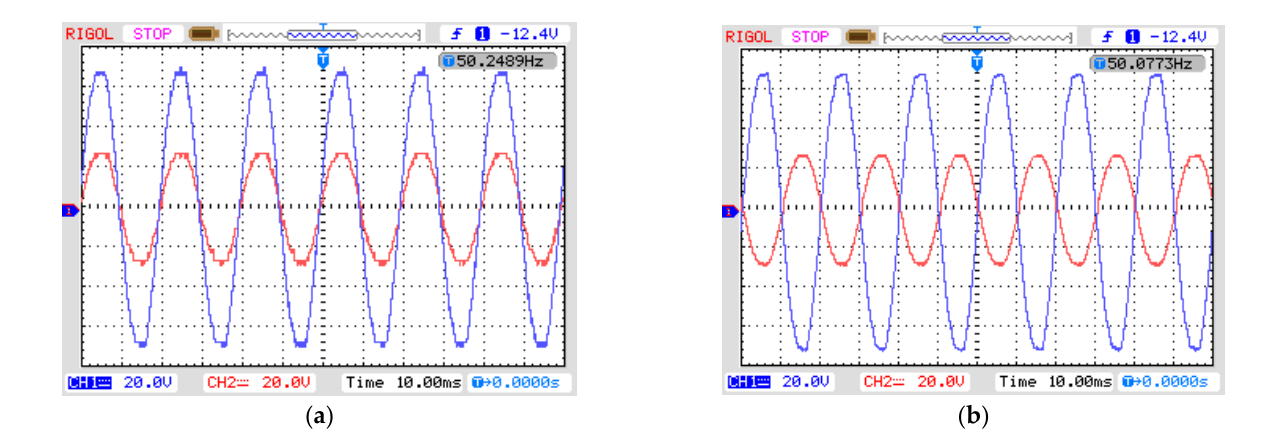
Figure 14. Practically obtained results of output voltage (red) with respect to input voltage (blue) for output step-down process in ( a ) non-inverted form and ( b ) inverted form.